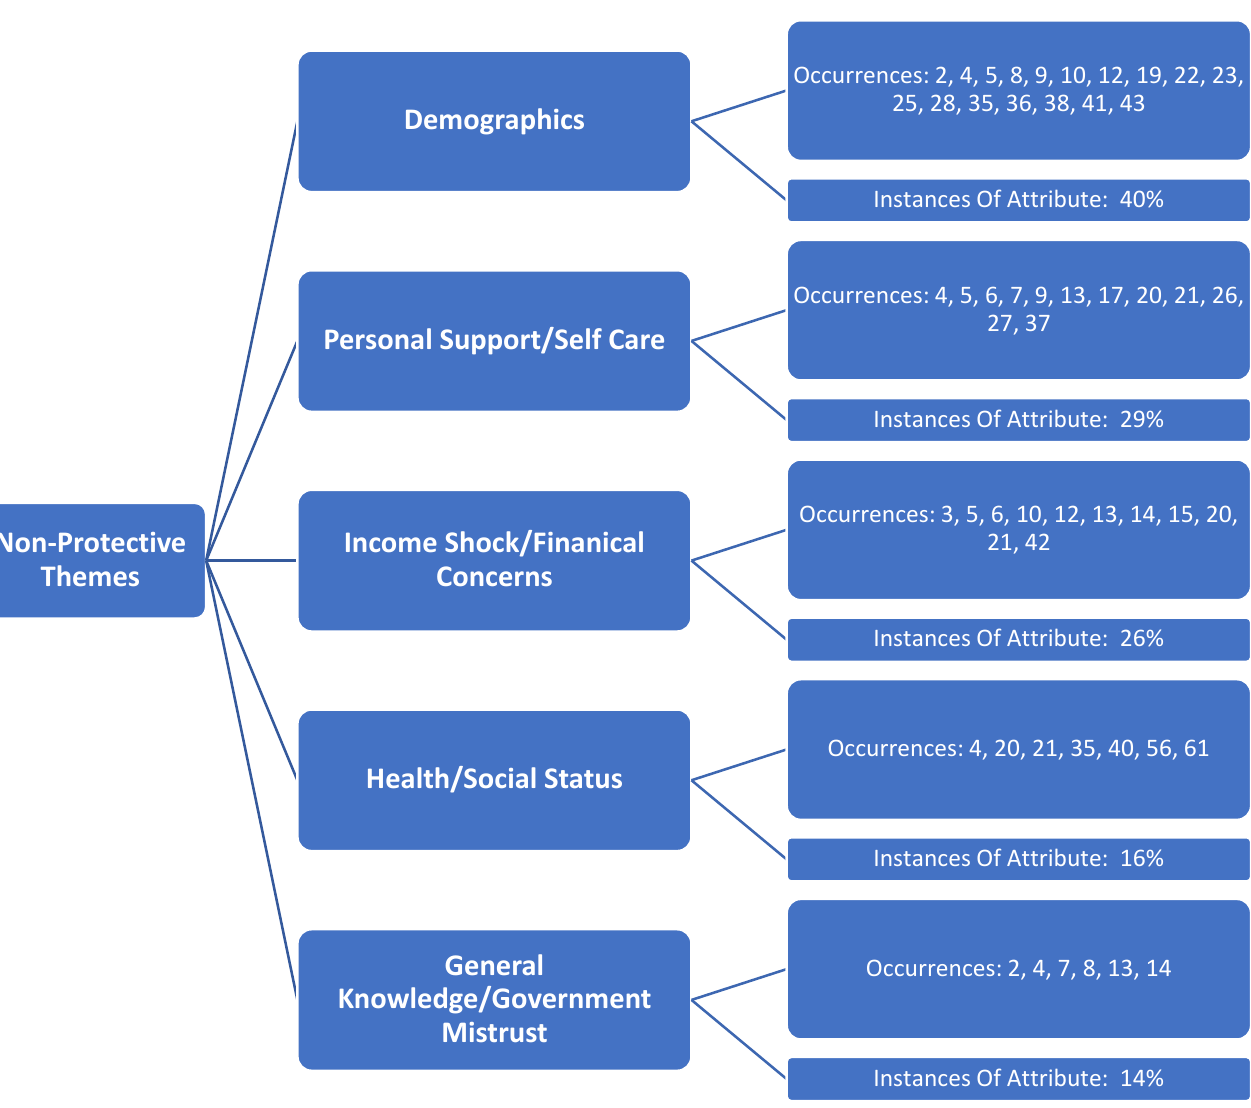
Figure 3. Identified themes (constructs) identified non-protective factors of mental health distress during the COVID-19 pandemic in the United States.